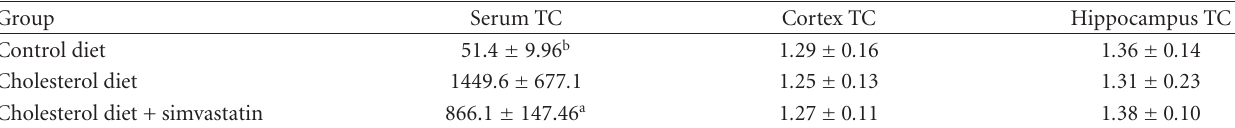
Figure 2: Simvastatin has no e ff ect on high-cholesterol diet-induced downregulation of tight junction proteins. Cryostat sections of the olfactory bulbs and hippocampus were incubated with fluorescently labeled antibodies against occludin and ZO-1, and representative images for each treatment group are shown. (a) Decreased ZO-1 immunostaining was observed in the olfactory bulbs and hippocampus of cholesterol-fed rabbits (supplemented with 2% cholesterol for 10 weeks). This e ff ect was not blocked by treatment with simvastatin (5mg/kg/day for 4 weeks). (b) Decreased occludin immunostaining was observed both in the olfactory bulbs and hippocampus of cholesterol-fed rabbits, and this e ff ect was not blocked by simvastatin (200 × ). Table 1: Concentration of total cholesterol (TC) in the serum, cortex, and hippocampus of rabbits fed a control diet, high-cholesterol diet, and high-cholesterol diet plus